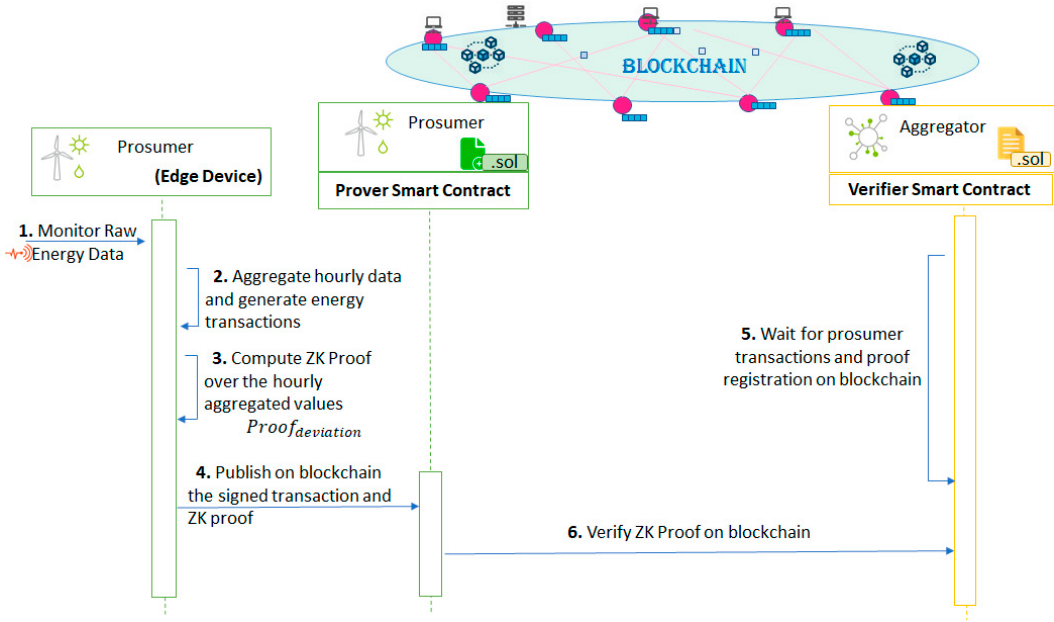
Figure 6. DR deviations detection process augmented with ZKP for data privacy.